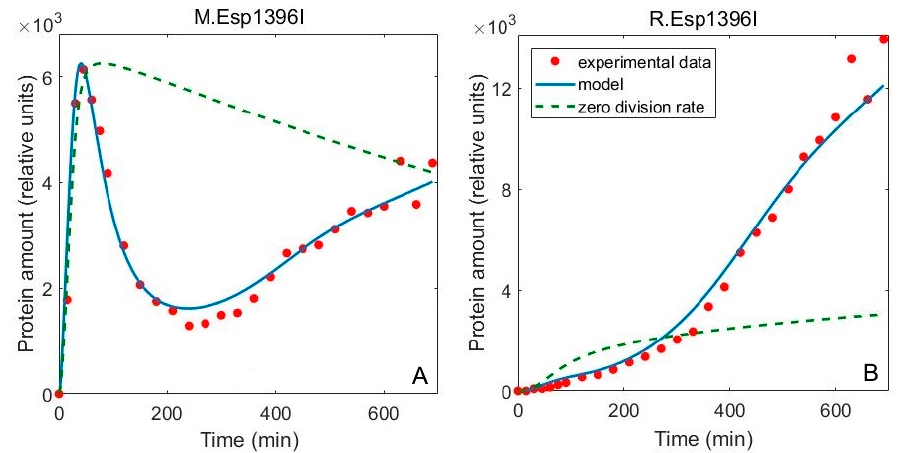
Figure 5. Excluding population dynamics from the full model. The blue solid line represents the full model fitted to experimental data (red dots) for ( A ) methyltransferase and ( B ) restriction endonuclease, while the green dashed line is obtained by excluding the population dynamics from the model and running the simulation with unchanged values for the rest of the parameters. To better compare the shape of the curves, the model without the population dynamics is rescaled, so that the maximal value reached by M is the same as in the full model.